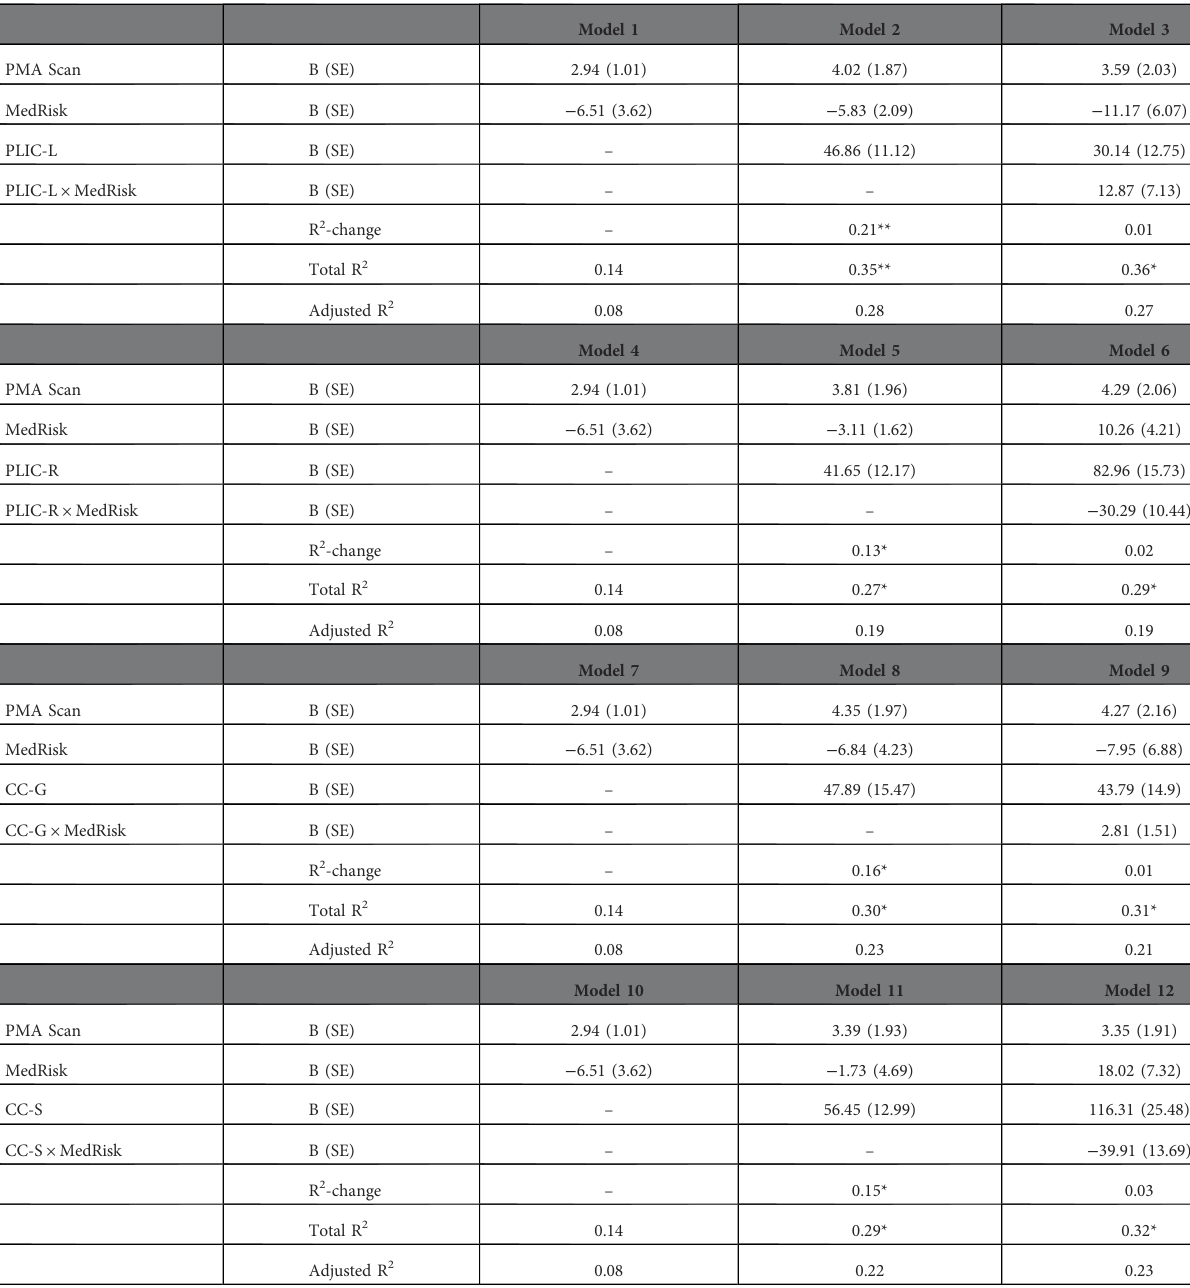
TABLE 3 Prediction of bayley-III language scores at 2 years of corrected-age from tract MK values of PLIC and corpus callosum beyond covariates of post menstrual age at DKI scan (PMA scan) and neonatal medical complications